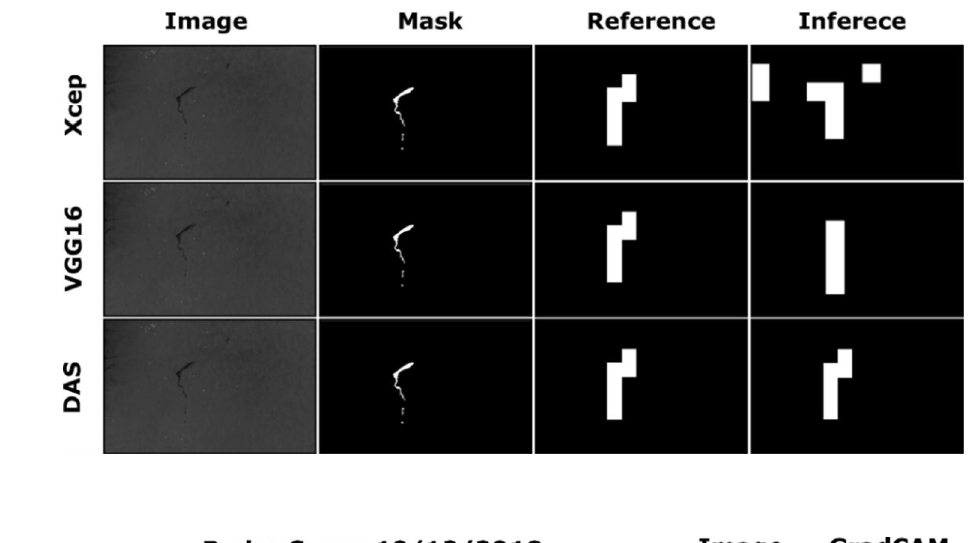
Fig. 13 Grad-CAMs produced by DAS with images from the Oil Spill dataset (19/12/2018) for class Oil. Only patches predicted by the model as belonging to this class are